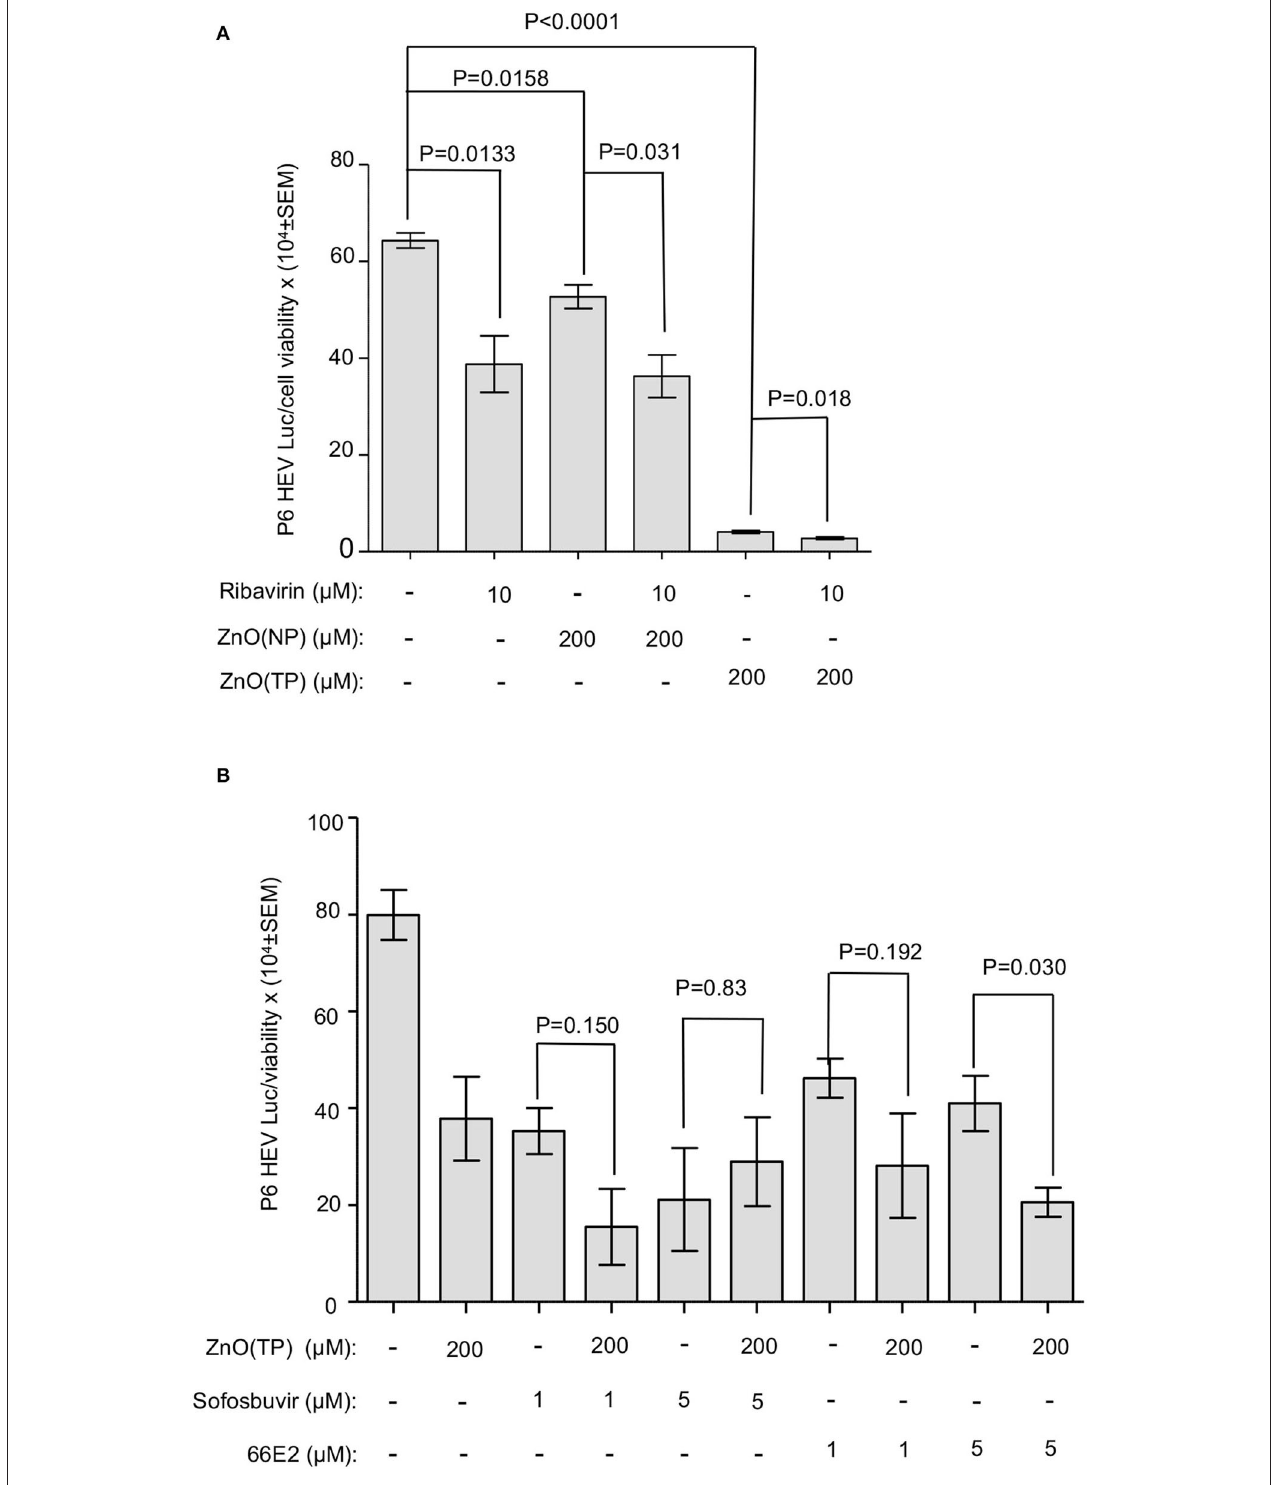
FIGURE 6 | Effect of co-treatment of zinc compounds and known anti-HEV compounds on g3-HEV replication. (A) Measurement of G-Luc activity in Huh7 cells expressing in vitro synthesized capped RNA of a g3-HEV-Luc replicon and treated for 3 days (once daily) with the indicated concentration of different compounds. G-Luc values were normalized to that of the cell viability and represented as mean ± SEM. (B) Measurement of G-Luc activity in Huh7 cells expressing in vitro synthesized capped RNA of a g3-HEV-Luc replicon and treated for 24h with the indicated concentration of different compounds. G-Luc values were normalized to that of the cell viability and represented as mean ± SEM of three independent